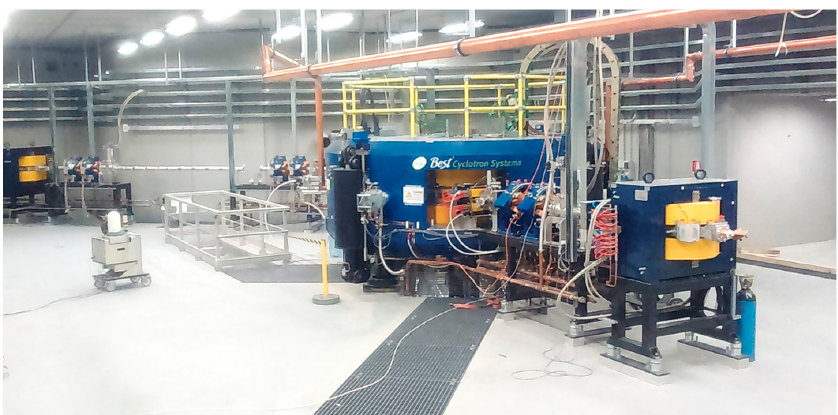
Figure 2. The new high-energy (70 MeV) and high-current (750 μ A) proton-beam cyclotron installed at LNL-INFN (Legnaro). One of the two main switching magnets may be seen on the right.